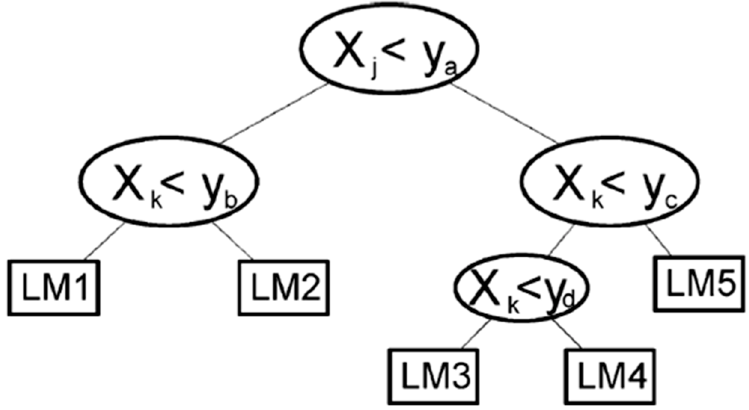
Figure 4. The typical architecture of a regression tree model; LM, linear model.